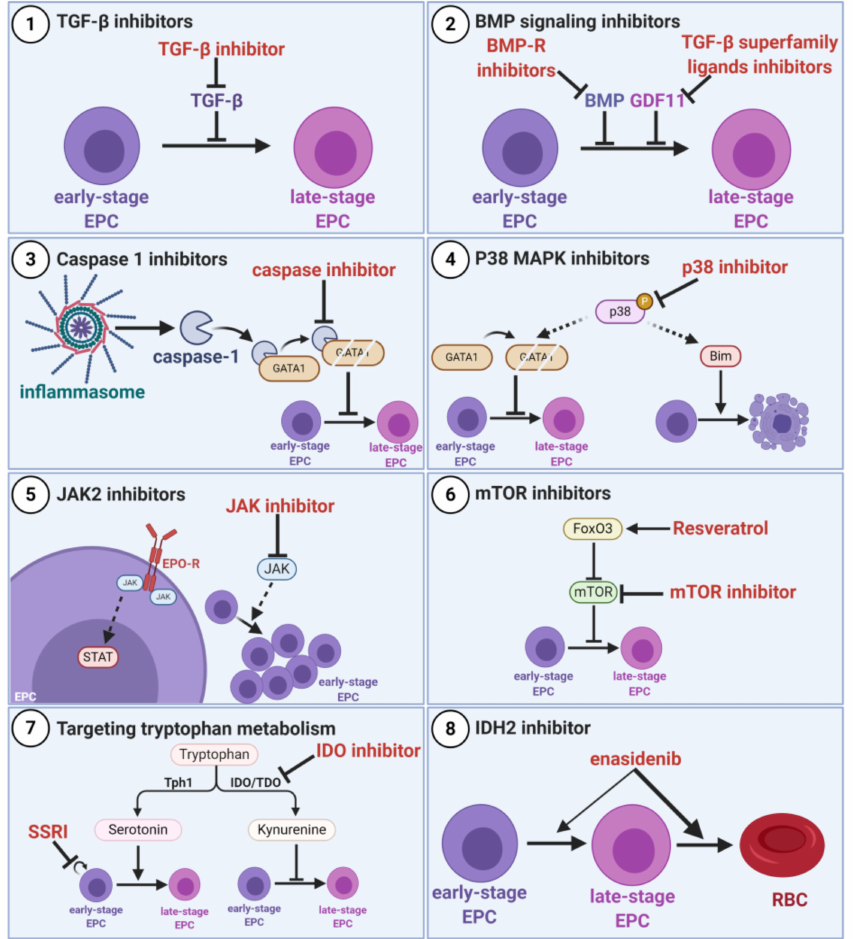
Figure 4. Targeting EPC expansion as a novel therapeutic strategy. Cancer-induced dysregulation of erythropoiesis resulting in the differentiation arrest of EPCs and their expansion may be diminished by different agents. Inhibitors of ( 1 ) transforming growth factor β (TGF- β ) and ( 2 ) BMP signaling rescue maturation arrest. ( 3 ) Caspases inhibitors inhibit GATA1 cleavage triggered by the inflam- masome. ( 4 ) P38 inhibitors promote differentiation and decrease the apoptosis of EPCs. ( 5 ) JAK inhibitors decrease activation of EPO-induced signaling, which decreases EPCs expansion. ( 6 ) mTOR inhibitors and inducers of FoxO3 promote differentiation of early-stage EPCs. ( 7 ) Increasing serotonin (5-HT) concentration with either selective serotonin reuptake inhibitors (SSRIs) or inhibitors of the kynurenine metabolism pathway promotes differentiation of EPCs. ( 8 ) Enasidenib, an inhibitor of mutated IDH2 promotes terminal differentiation of